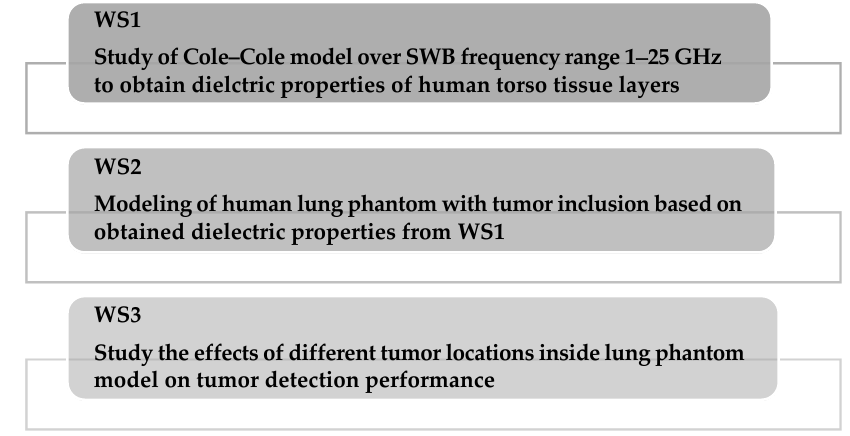
Figure 1. Workflow stages for this study.